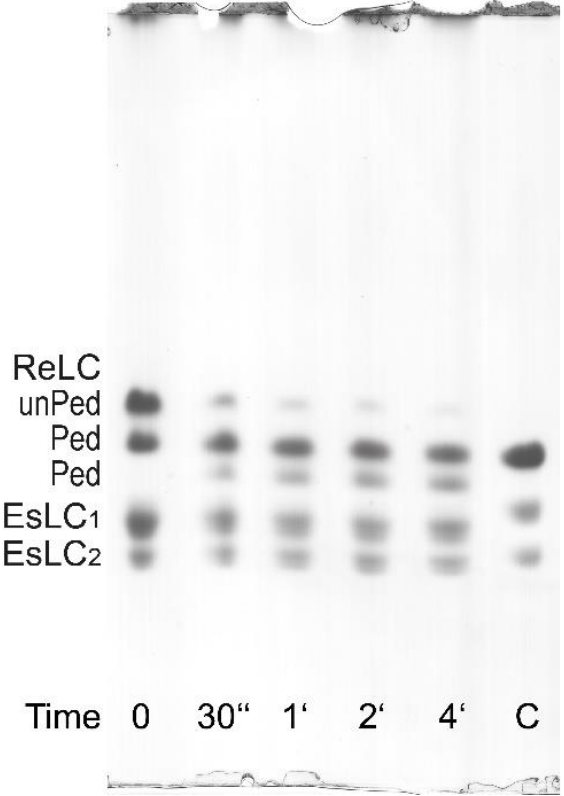
Figure 7. Phosphorylation assay of the purified bovine tracheal smooth muscle myosin ReLC on UG PAGE. As indicated by the labels on the left, the top bands correspond to unphosphorylated ReLC (unPed); the second and the third bands correspond to phosphorylated ReLC (Ped). The lower doublets correspond to pairs of the EsLCs and are present in all lanes. The phosphorylation assay was performed at 0 ◦ C (on ice) by adding MgATP in the presence of 0.1 mM CaCl 2 . The decreasing intensity of the top bands and the increasing intensity of the third bands show the presence of the endogenous CaM/MLCK complex. For comparison, a phosphorylated turkey gizzard myosin (lane C ) is included.